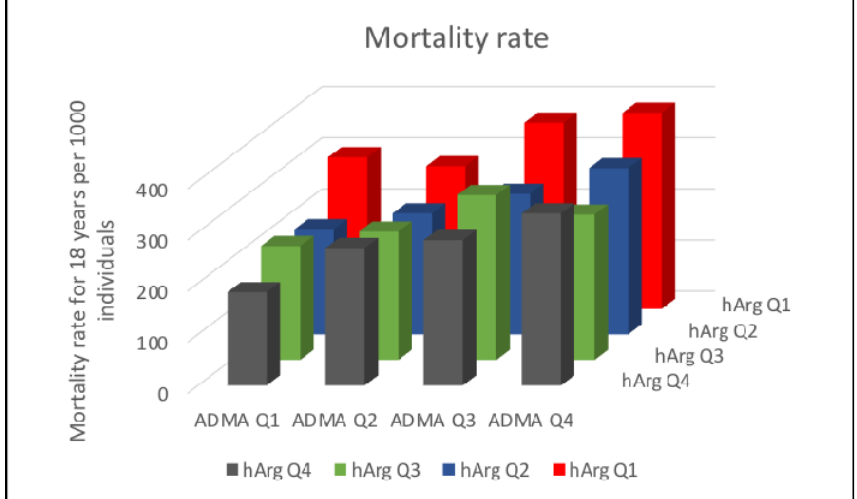
Figure 2. Crude mortality rates for 18 years of follow-up and quartiles of homoarginine (hArg) and asymmetric dimethylarginine (ADMA). The depicted quartiles (Q) are as follows: hArg Q1: 0.18–1.13 µmol/L, hArg Q2: 1.14–1.55, hArg Q3: 1.56–2.06 µmol/L, hArg Q4: 2.07-5.40, ADMA Q1: 0.14–0.46 µmol/L, ADMA Q2: 0.46–0.53 µmol/L, ADMA Q3: 0.53–0.61 µmol/L, ADMA Q2:0.62–1.37 µmol/L.